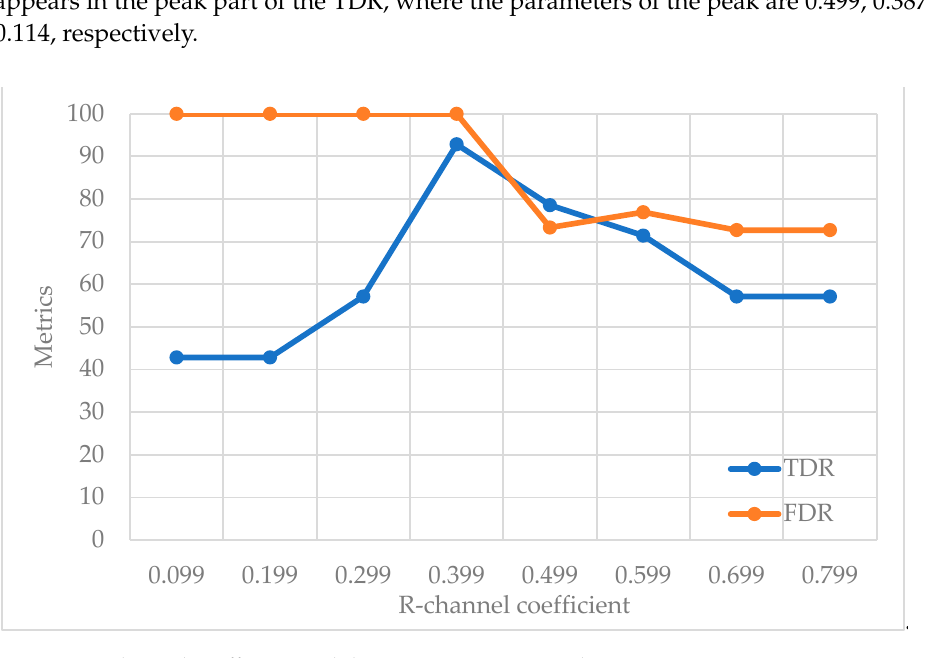
Figure 4. R channel coefficient and detection accuracy graph.